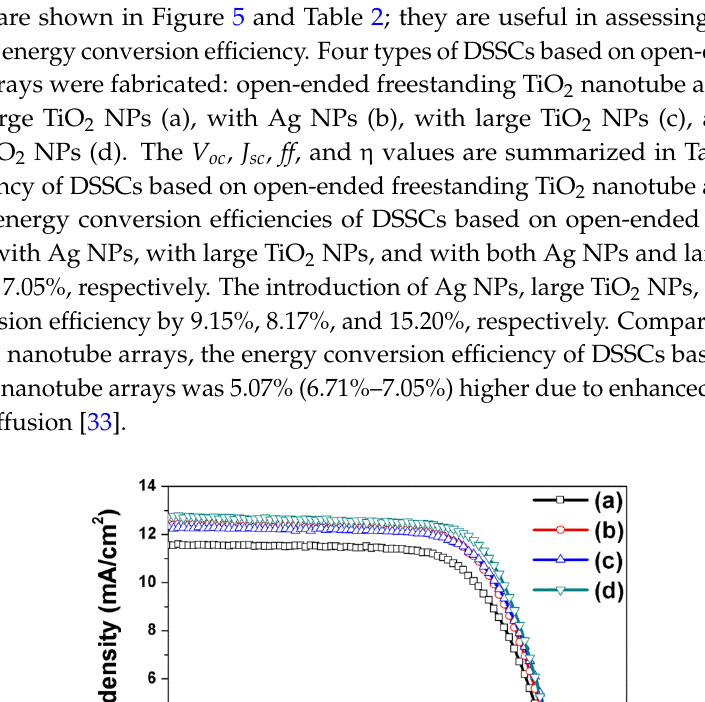
Table 1. Photovoltaic properties of dye-sensitized solar cells (DSSCs) based on closed-ended freestanding TiO 2 nanotube arrays.